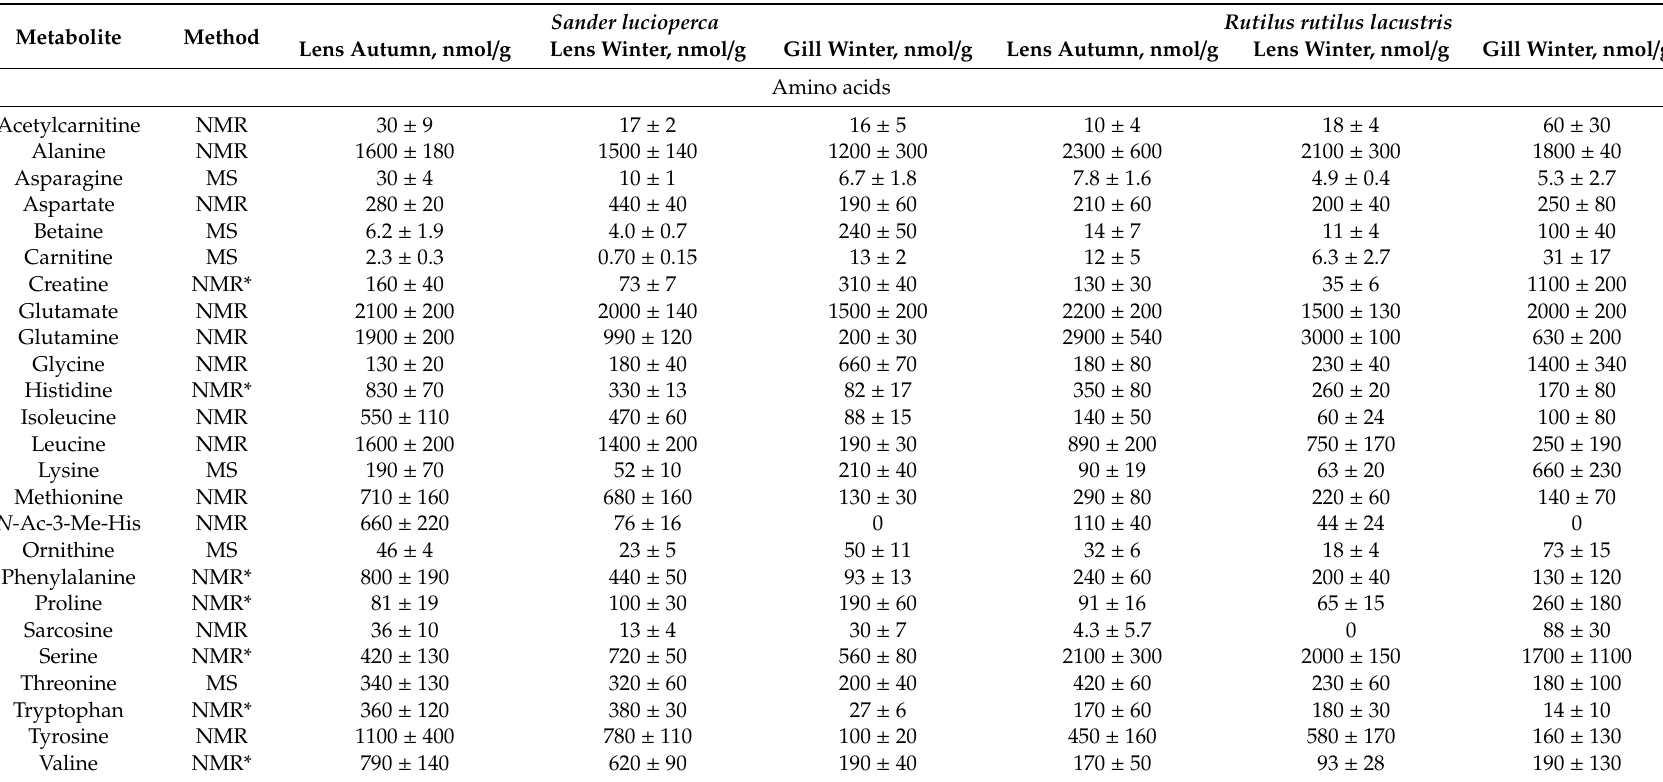
Table 1. Concentrations of metabolites in lenses and gills of S. lucioperca and R. rutilus lacustris caught in the Ob reservoir in late autumn and